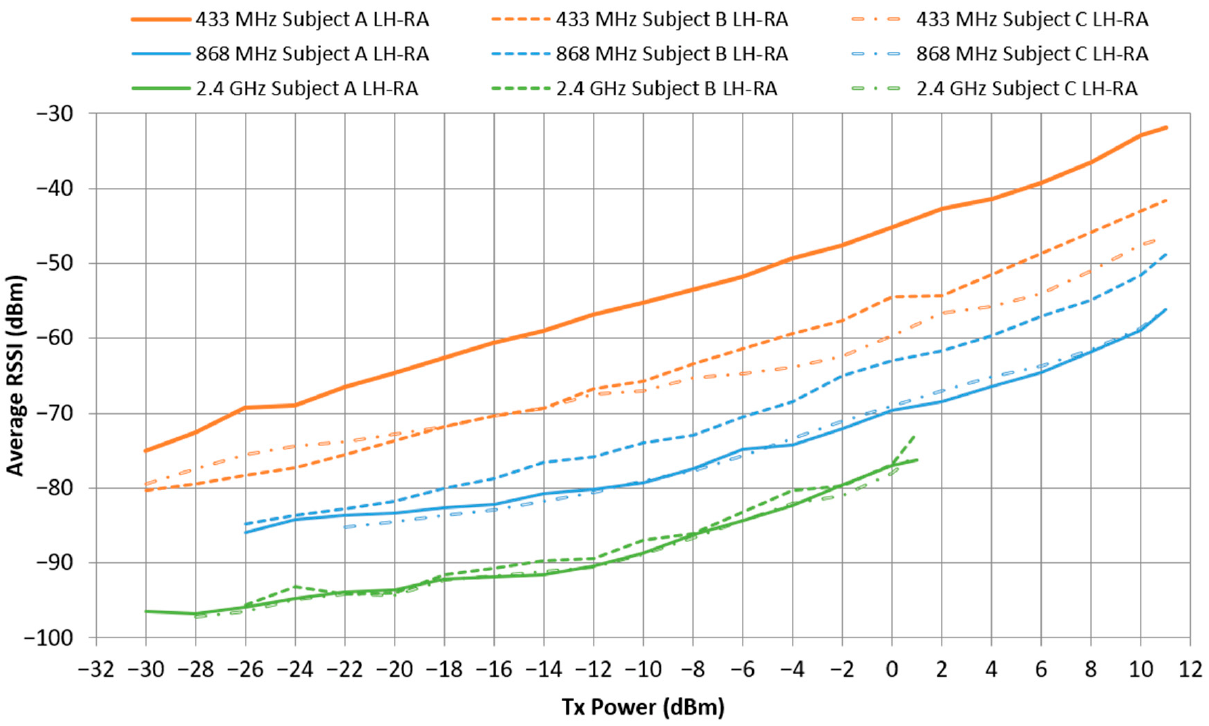
Figure 13. Average RSSI in the walking scenario for all subjects and frequencies: sender node located on the right ankle.